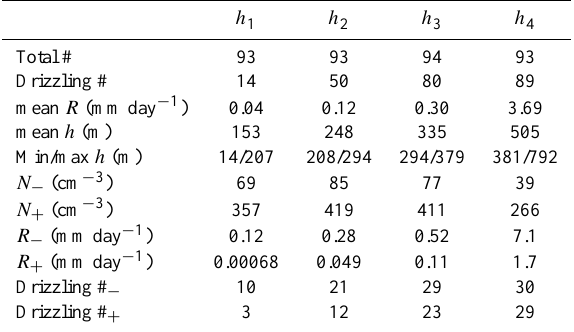
Table 1. Mean values of cloud thickness h , PCASP aerosol concen- tration N , and precipitation rate R in the four cloud thickness bins ( h 1 , h 2 , h 3 , h 4 from bin with thinnest to thickest clouds). Total # indicates the total number of points (10km averages) in each bin, and drizzling # indicates the number of those points where f > 0. x − and x + indicate the mean values of x in the population with top and bottom 33% values of N in each